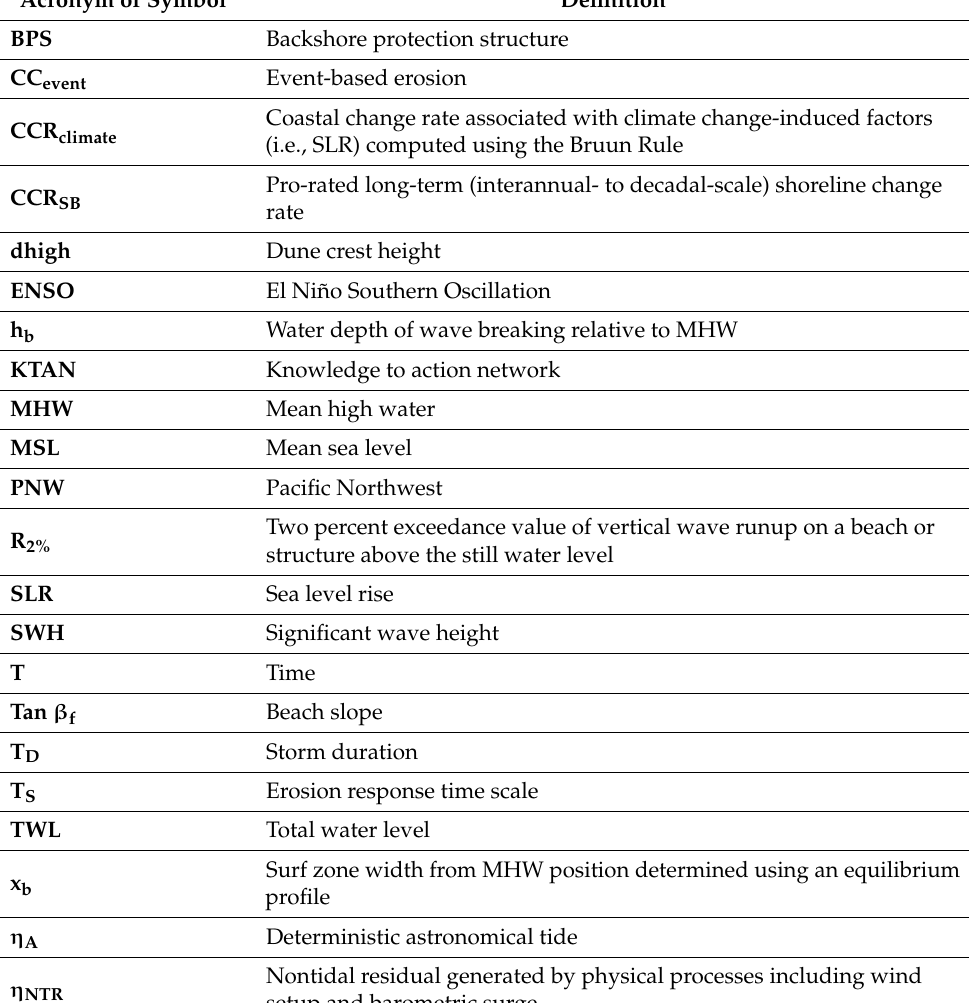
Table A2. List of symbols and